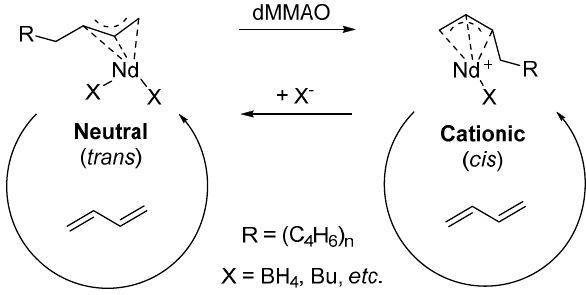
Figure 3. Plausible mechanism of stereospecificity change of butadiene polymerization at low dMMAO concentration.